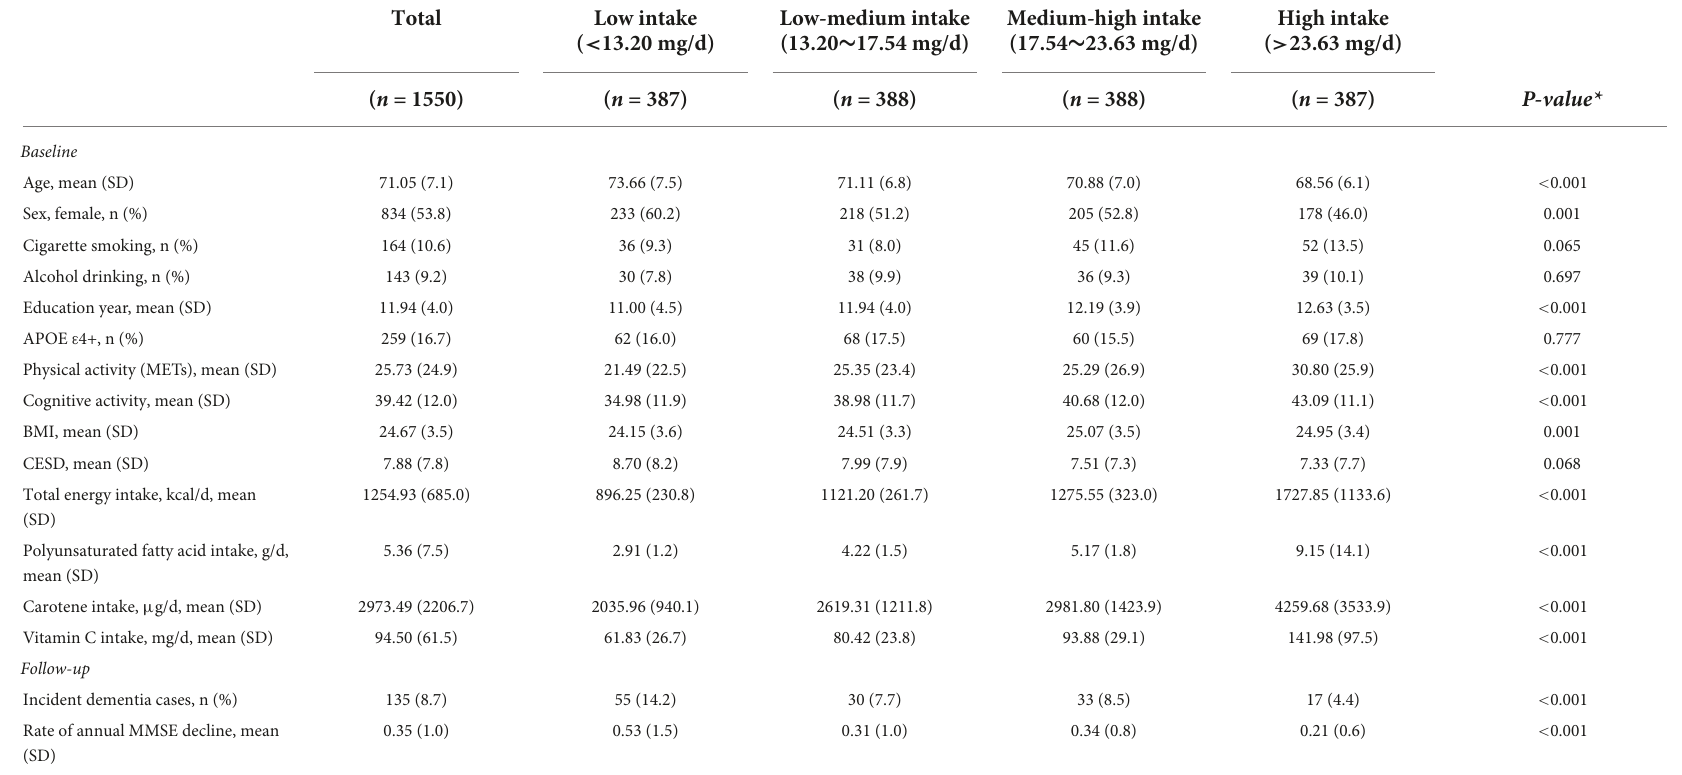
TABLE 1 Characteristics of participants by groups of vitamin E